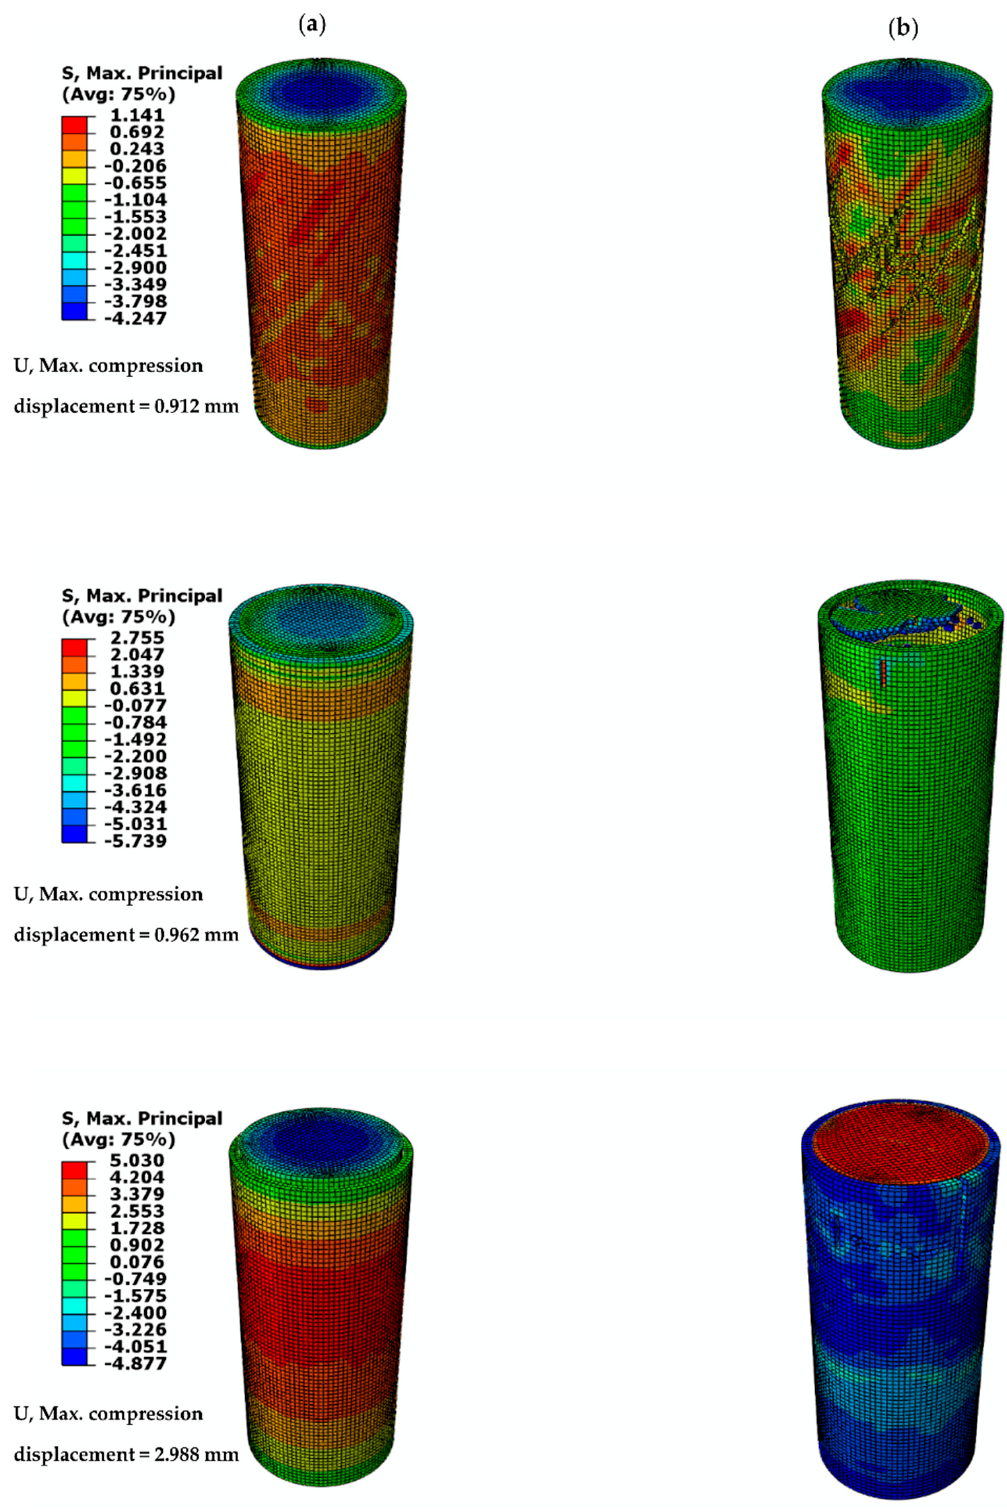
Figure 18. The failure mode of 160 mm samples with max principle stress. ( a ) before failure ( b ) after failure.